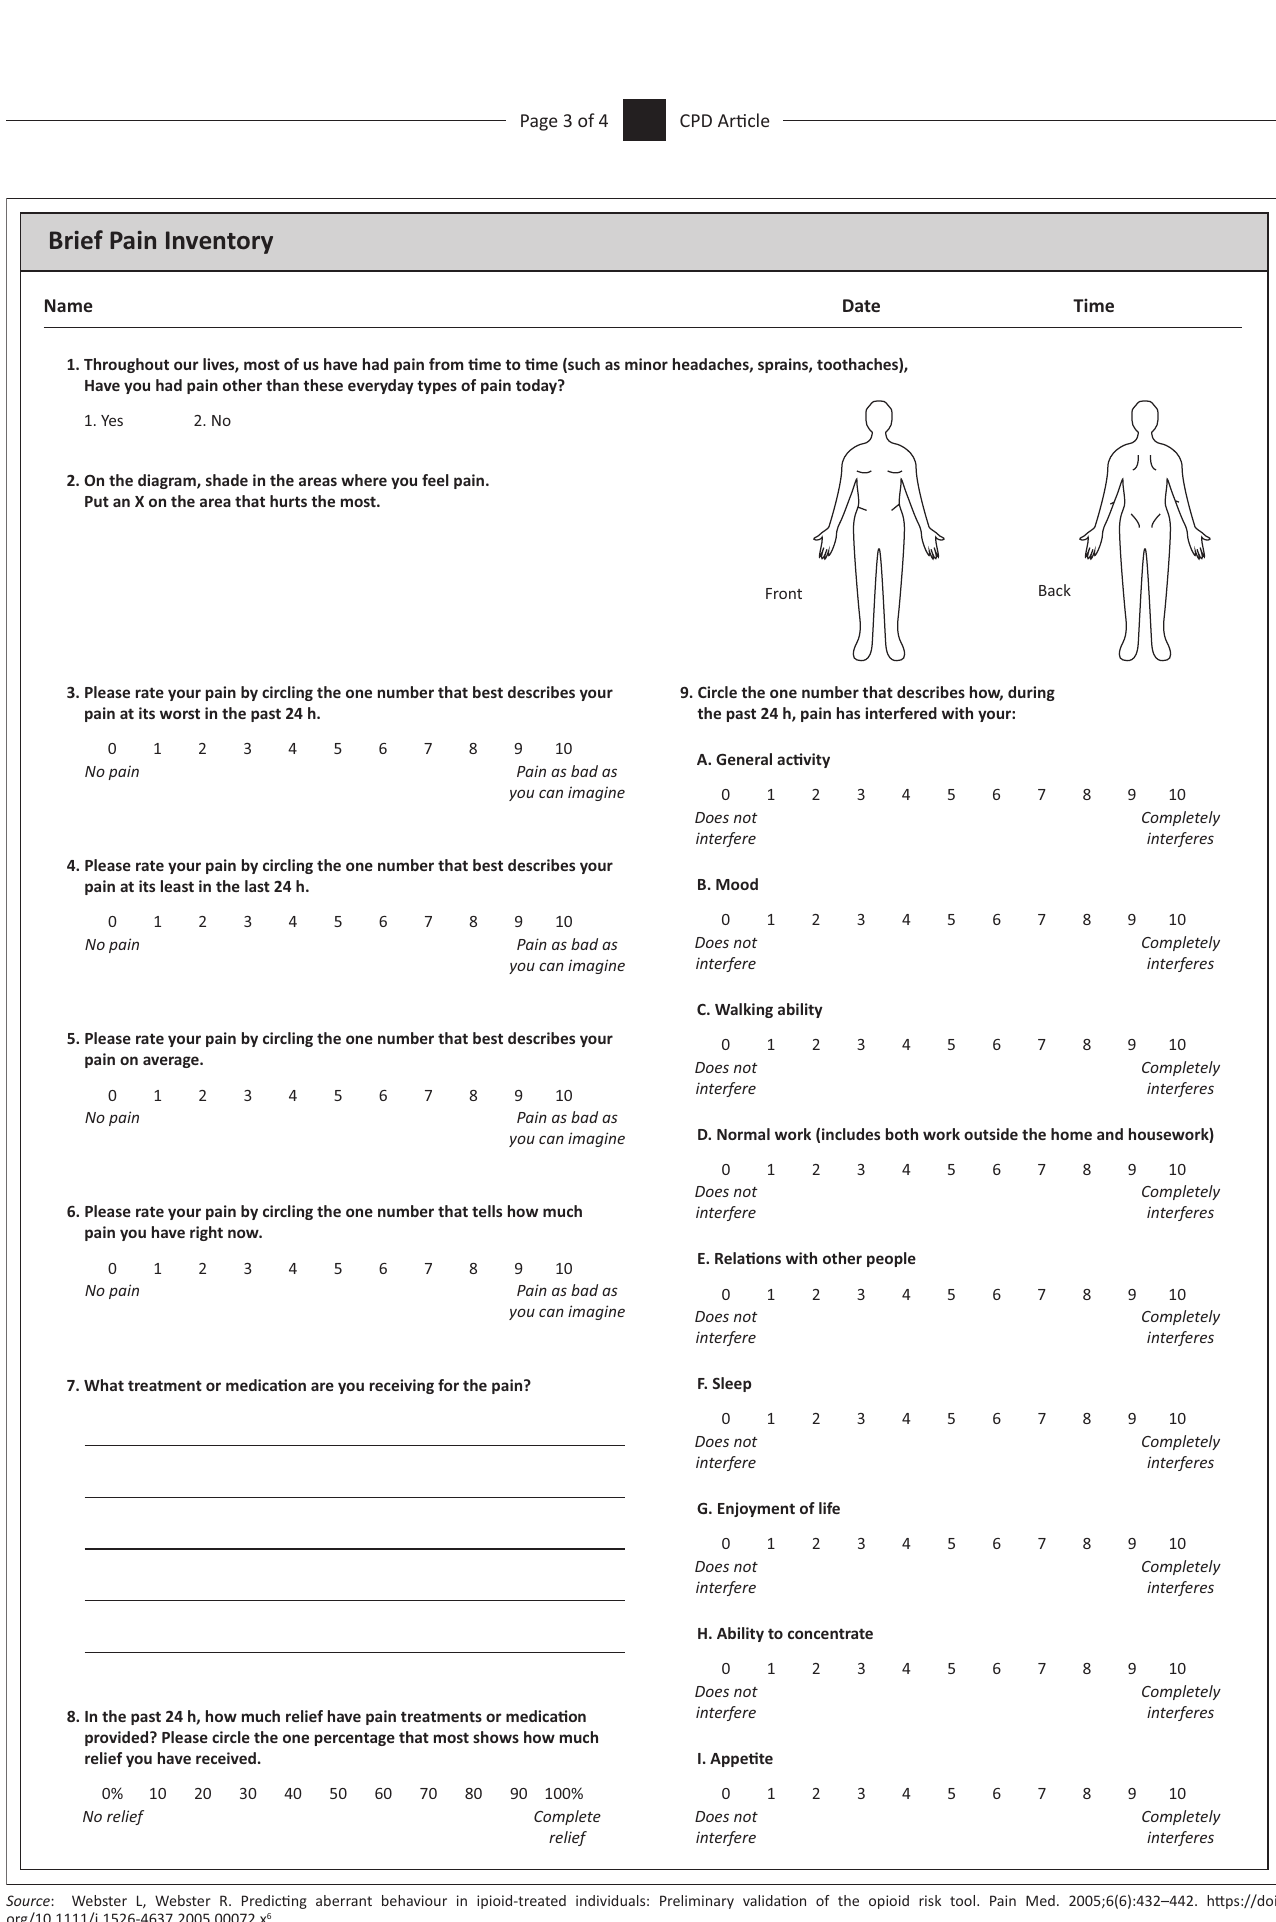
FIGURE 1: The Brief Pain